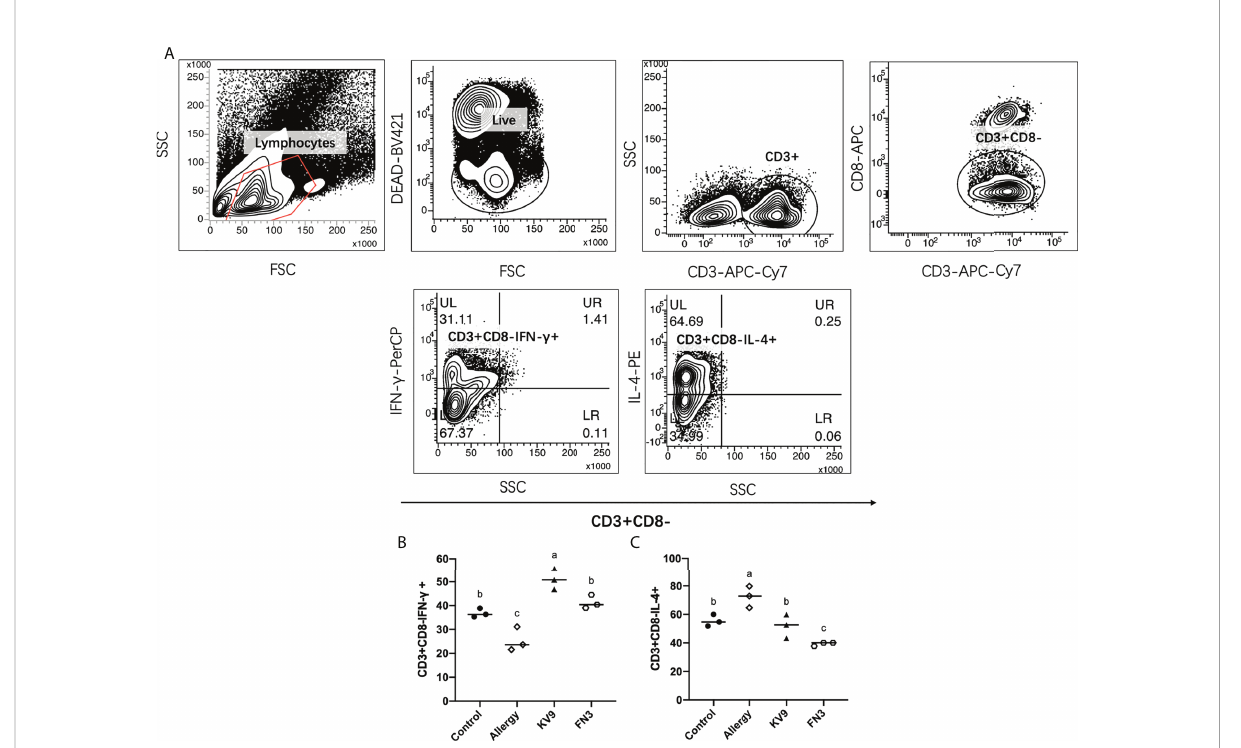
FIGURE 9 The effect of probiotics on T cells. The gating strategy (A) and the effect of oral administration of KV9 and FN3 on populations of CD3+CD8 − IFN- g + T cells (B) and CD3+CD8 − IL-4+ T cells (C) in the spleen from different groups of mice. Identical lowercase in the fi gure indicates the lack of signi fi cance ( p <